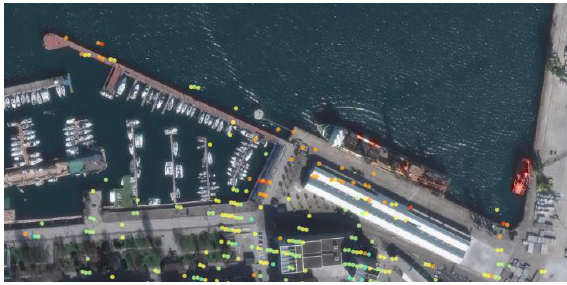
Figure 6 . Details of the PS and their location in the Vigo Pier